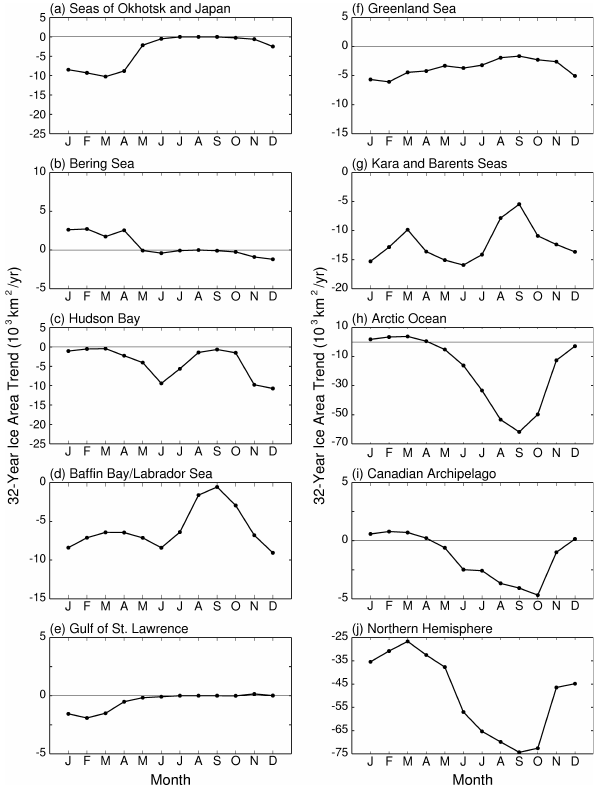
Fig. 6. Monthly deviations of the sea ice areas for (a) Seas of Okhotsk and Japan, (b) Bering Sea, (c) Hudson Bay, (d) Baffin Bay/Labrador Sea, (e) Gulf of St. Lawrence, (f) Greenland Sea, (g) Kara and Barents Seas, (h) Arctic Ocean, (i) Canadian Archipelago, and (j) Northern Hemisphere.